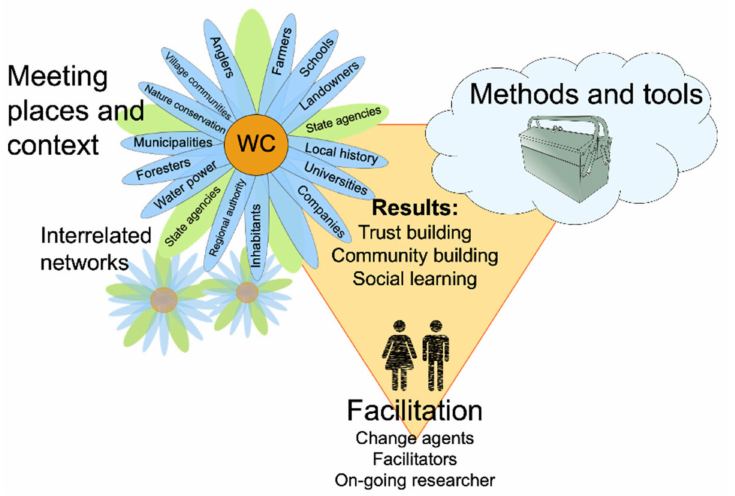
Figure 8. Three important parts for collaboration supporting structures